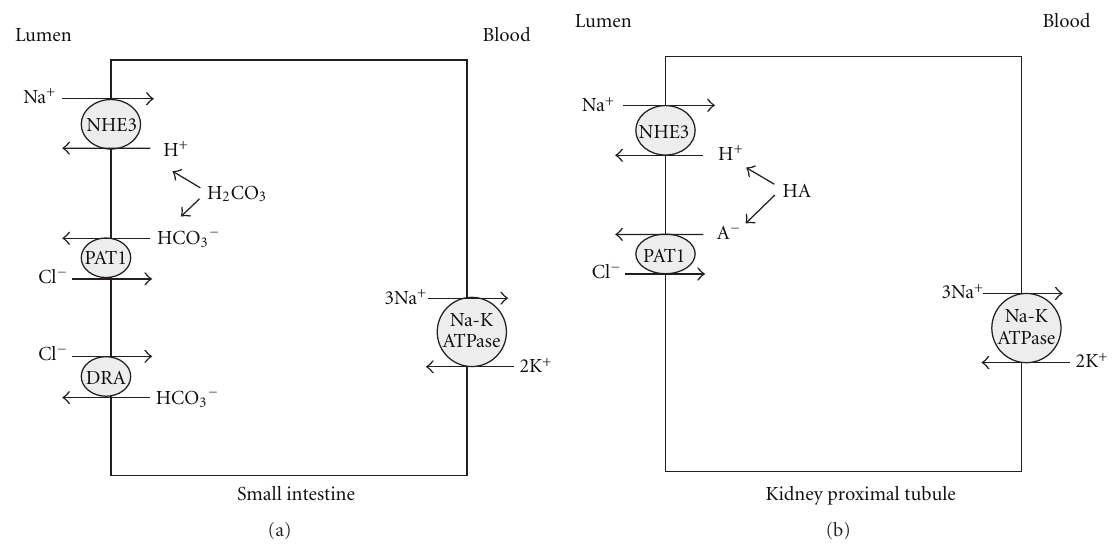
Figure 2: Localization of salt absorbing transporters in the small intestine (a) and kidney proximal tubule (b). NHE3: sodium hydrogen exchanger3: SLC9A3; PAT1: putative anion transporter 1: SLC26A6; DRA: down regulated in adenoma: